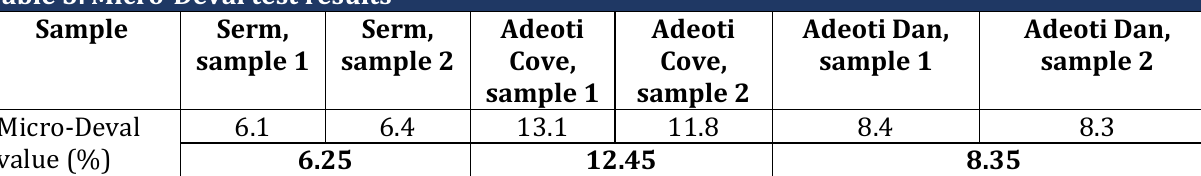
Table 3. Micro-Deval test results